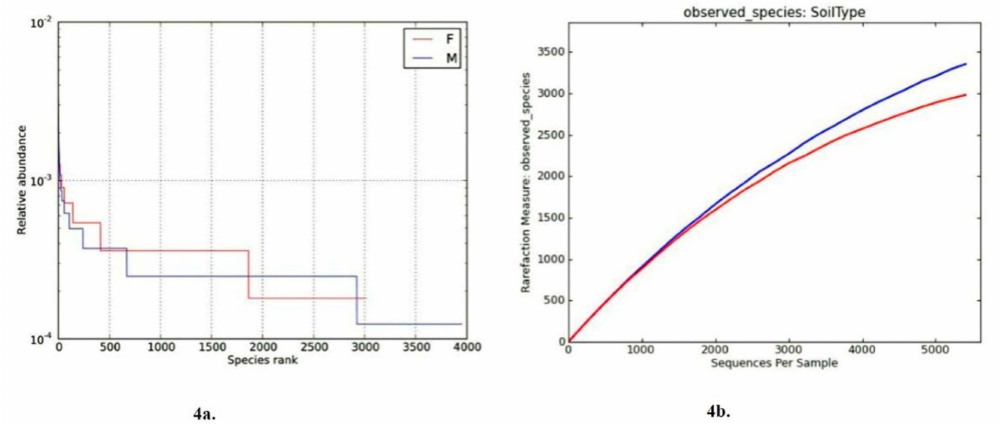
Figure 4. Microbial diversity in “Moitree” and “Farmer-2” cultivars: ( a ) rank–abundance curves for lentil cultivars Moitree (M) and Farmer-2 (F) resulting from Next Generation Sequencing (NGS) reads from the V5–V6 region of 16S rRNA genes from Bacteria and Archaea, in which Operational taxonomic units (OTUs) are based on 97% sequence similarities, and ( b ) rarefaction curves of OTUs (by Chao1 estimates) of lentil cultivars Moitree (M) and Farmer-2 (F) under rice-fallow